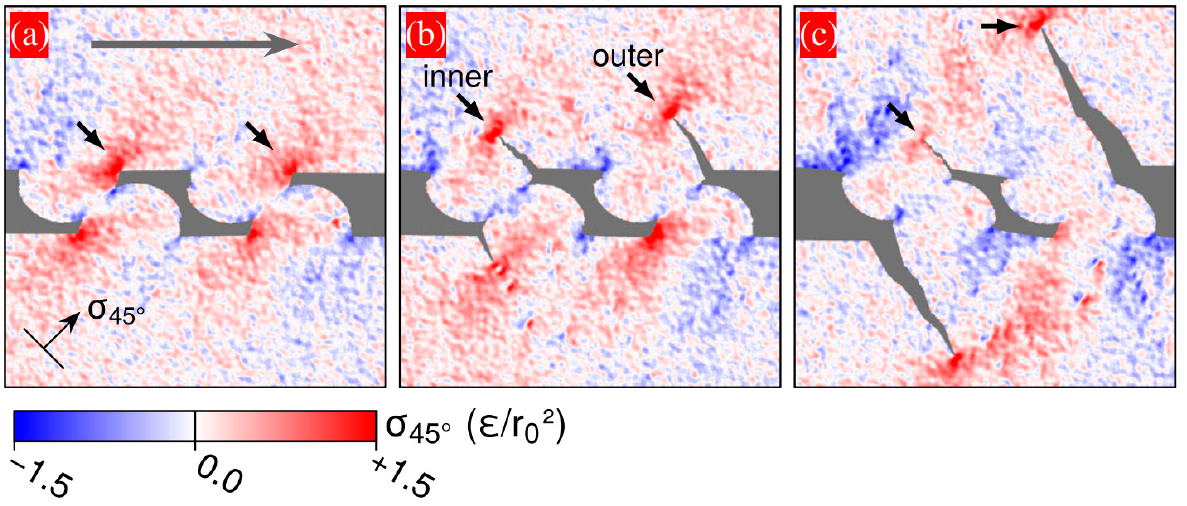
Figure 5. Crack shielding drives joint debris formation: ( a – c ) stress component driving the nucleation and propagation of the subsurface cracks, taken from [63].